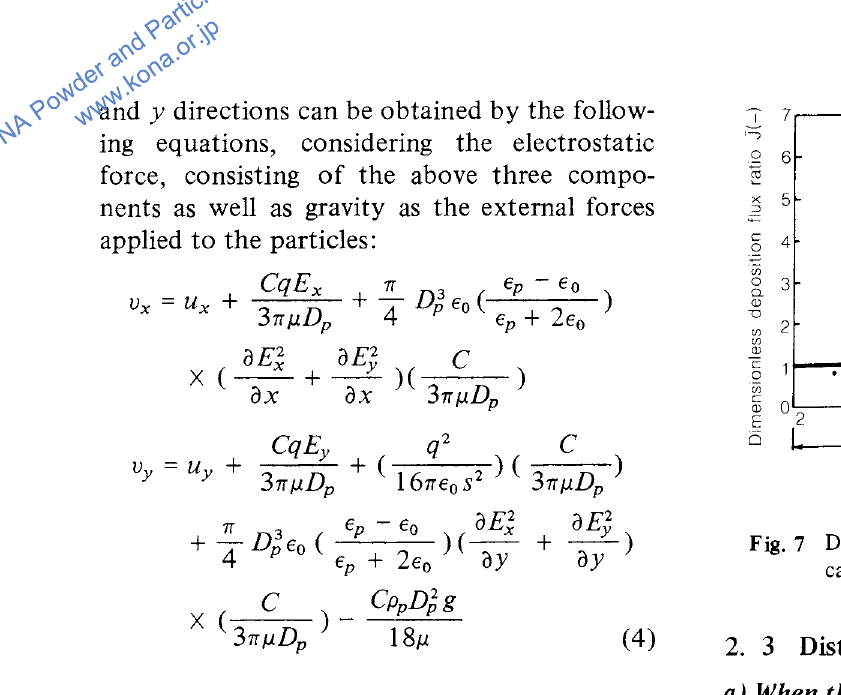
Fig. 7 Deposition flux distribution compared with calculated result (Dp = 0.62 pm)